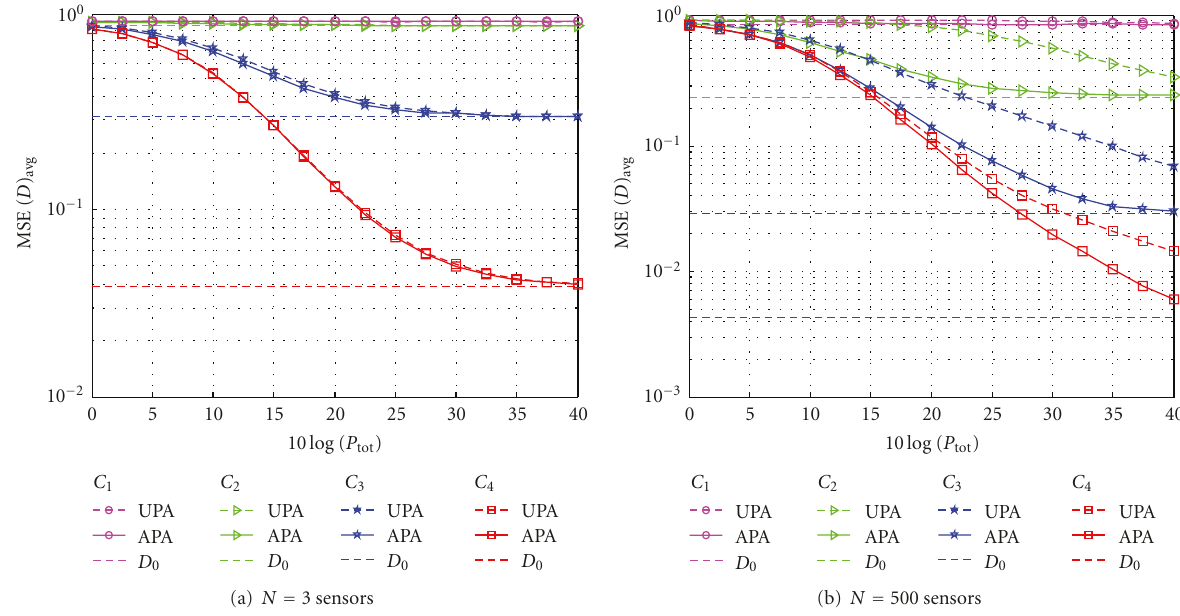
= (0 . 01,1,10), and ( C , h i , σ 2 ) N n i w i i = 1